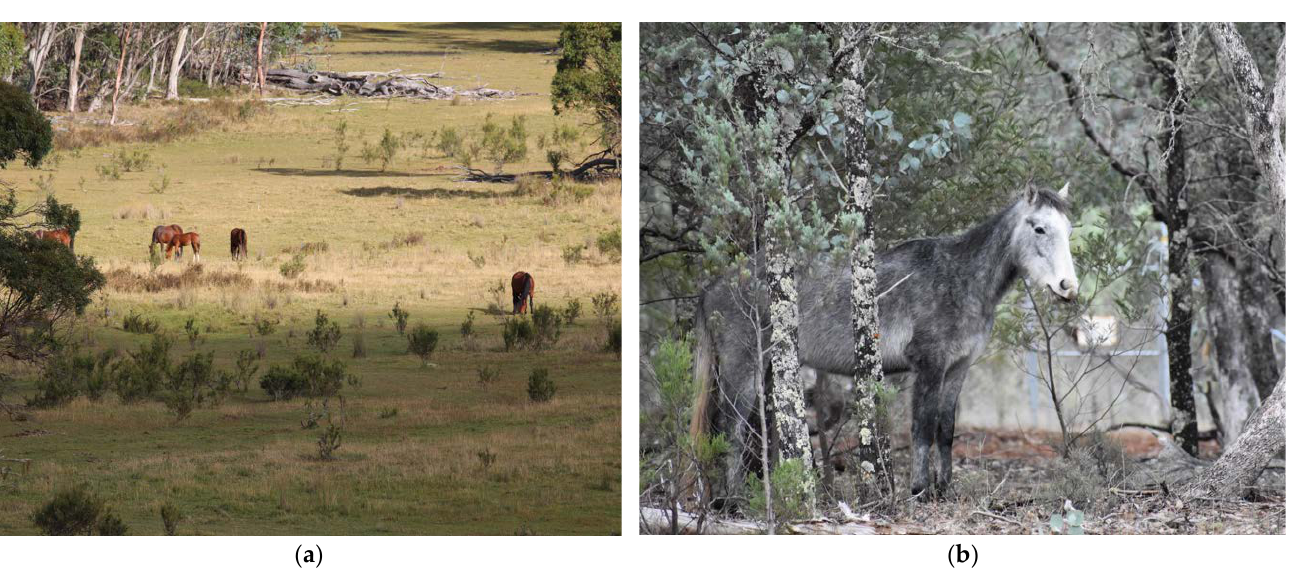
Figure 2. Horses grazing in different habitats in Kosciuszko National Park, Australia : ( a ) Horses are predominantly grazers; however, ( b ) shrubs and trees form a variable proportion of their diet, increasing when availability of grass is limited. Images A. M. Harvey.